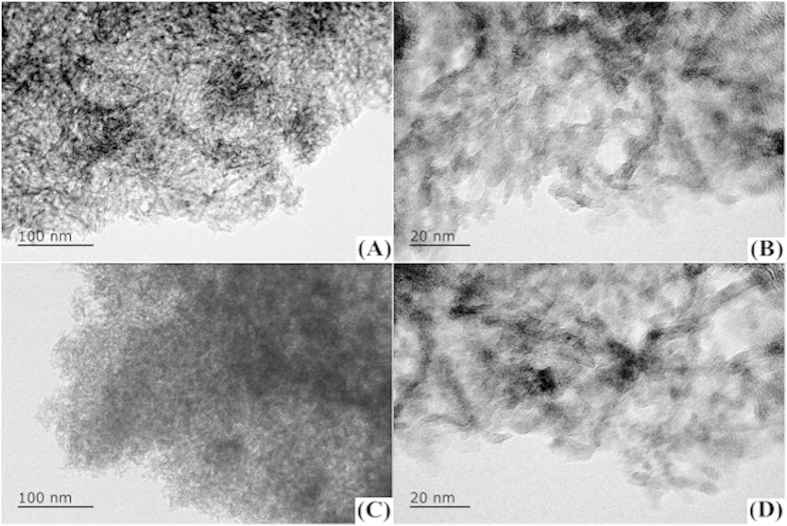
Transmission electron microscopy images of the synthetic Ni/Al2O3 catalyst (A) ×200k, (B) ×800k and synthetic Ni-PTA/Al2O3 catalyst (C) ×200k, (D) ×800k.